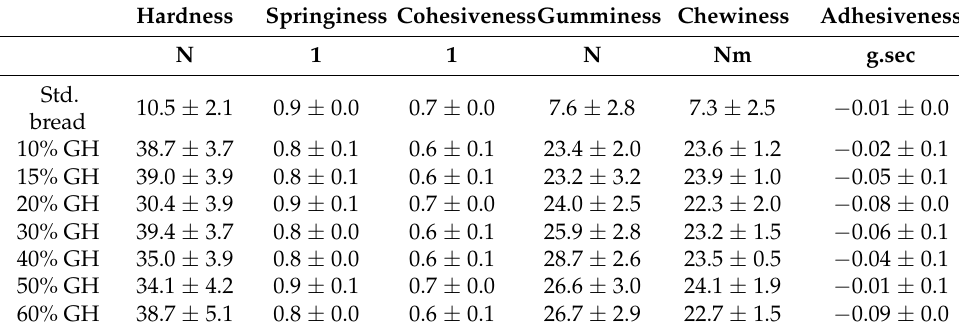
Table 3. Texture profile analysis of standard bread versus the GH